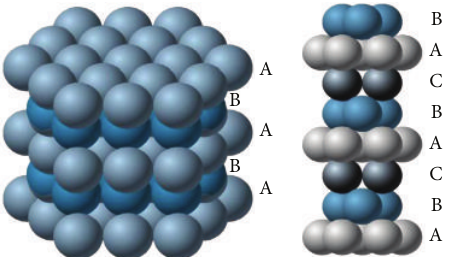
Figure 1: Three-dimensional arrays: (a) HCP, (b) CCP [3].